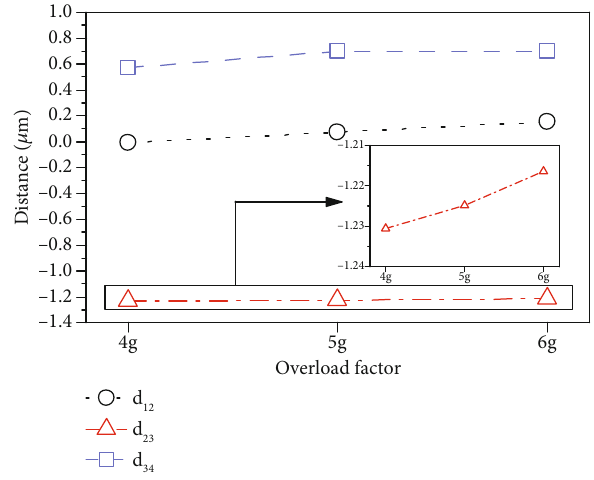
Figure 11: Variation in relative